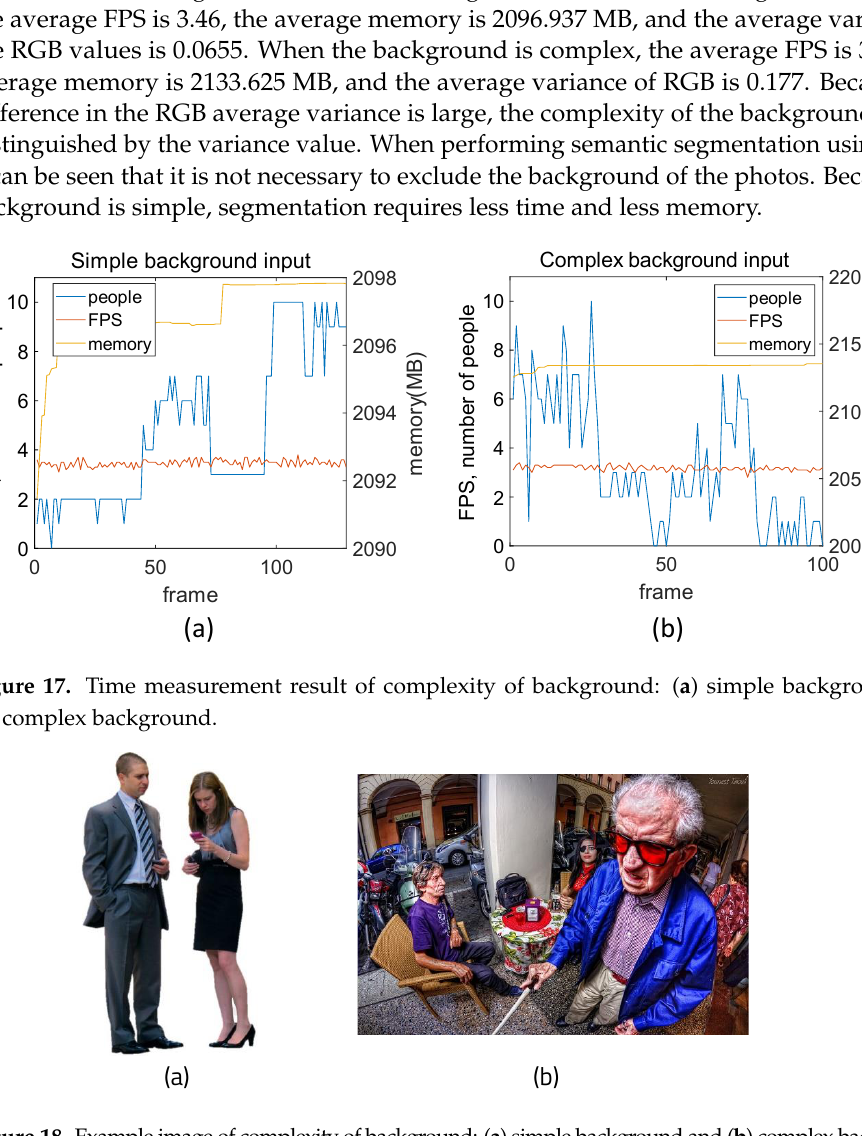
Figure 18. Example image of complexity of background: ( a ) simple background and ( b ) complex